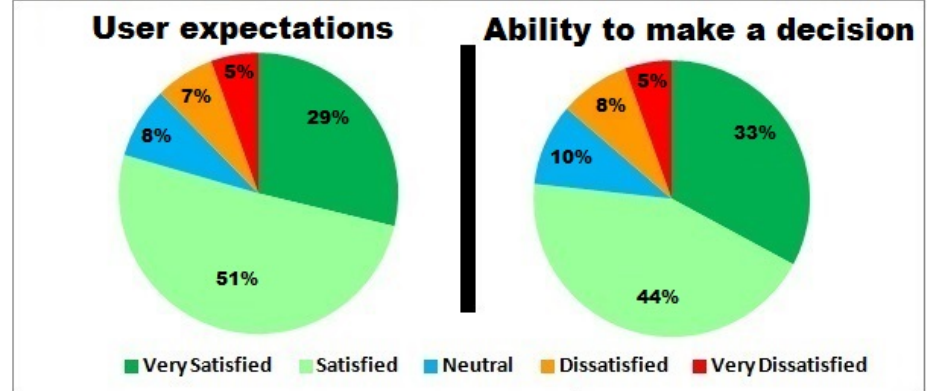
Figure 14. Users’ expectations and their ability to make the right decisions.